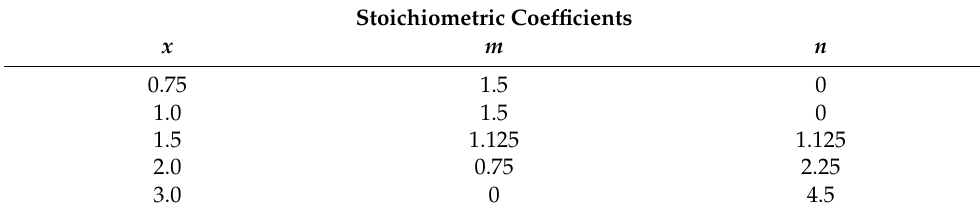
Table 1. Stoichiometric coefficients ( x , m , and n ) of Reaction